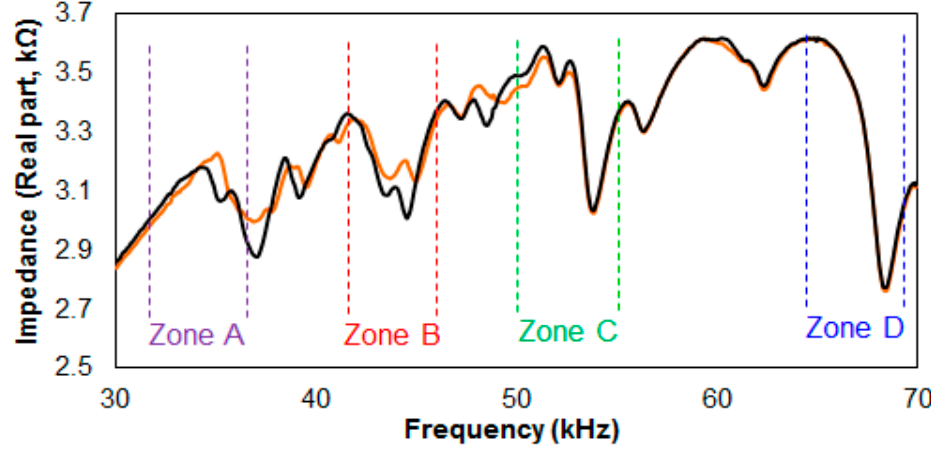
Figure 7. Impedance signatures from debonding T1 and T2 transducer attached stacks.